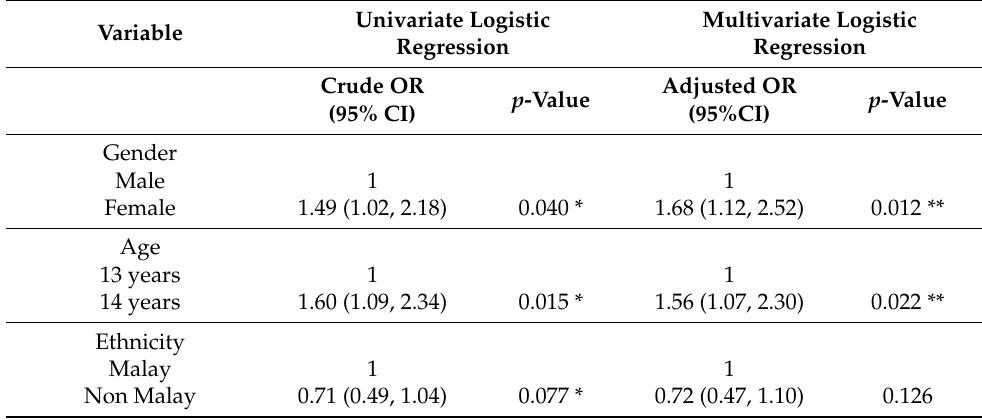
Table 4. Factors associated with adequate